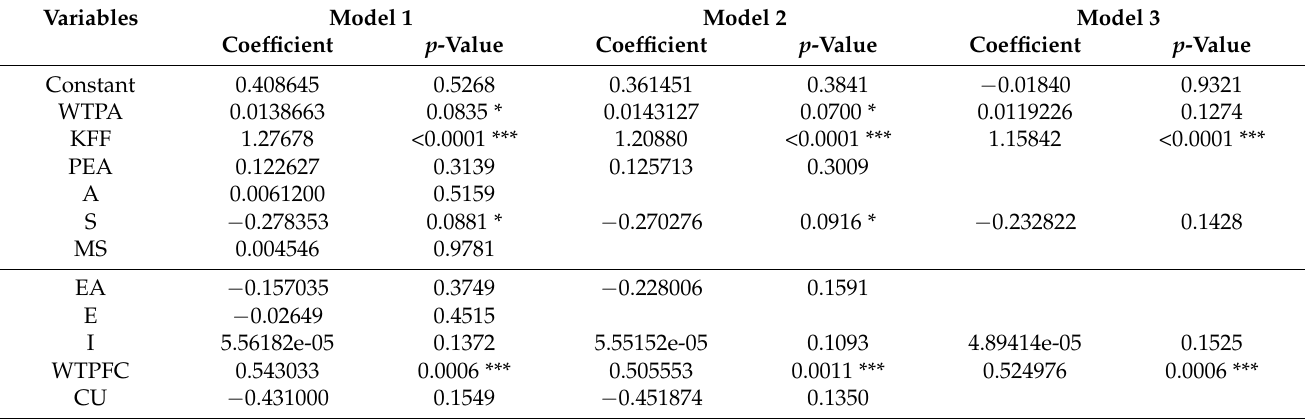
Table 4. Determinants of the hypothetical willingness to pay for alternative energies